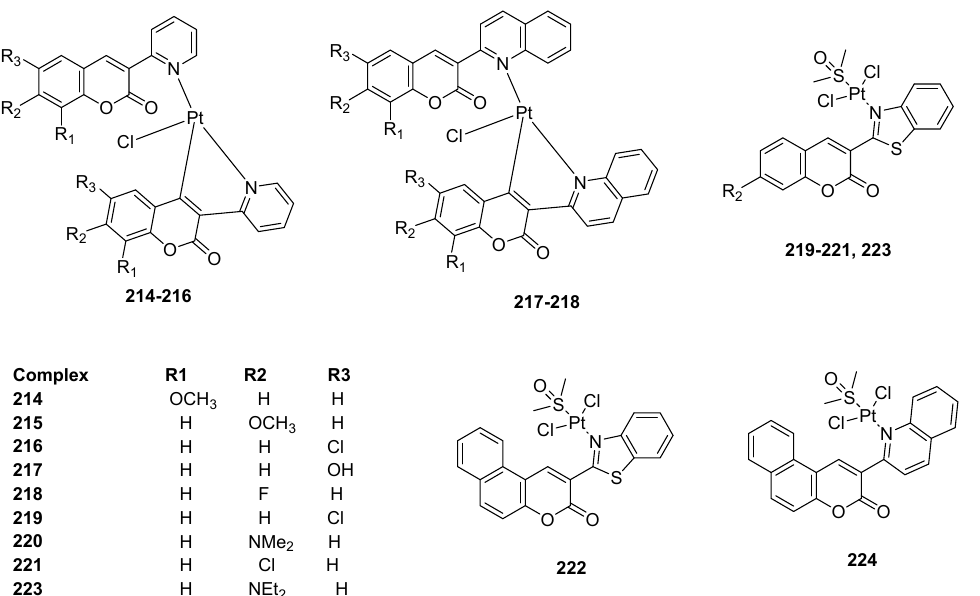
Figure 70. Chemical structure of derivatives 214–224.